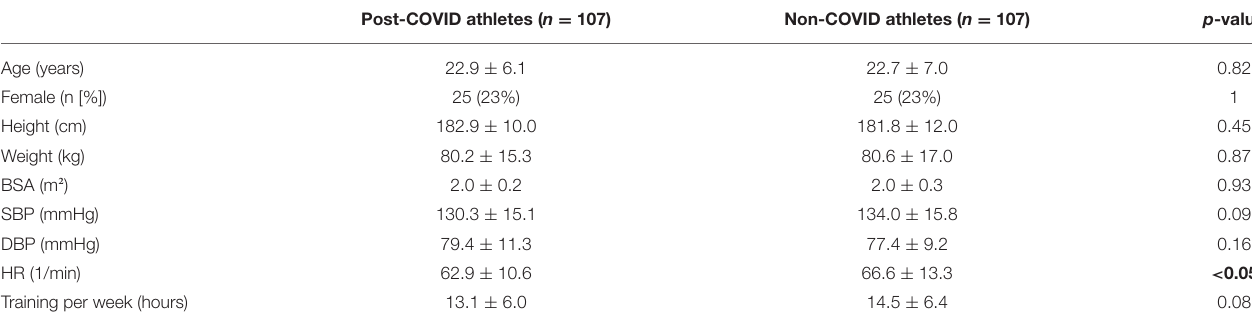
TABLE 1 | Baseline characteristics of the post-COVID and the non-COVID athlete groups.